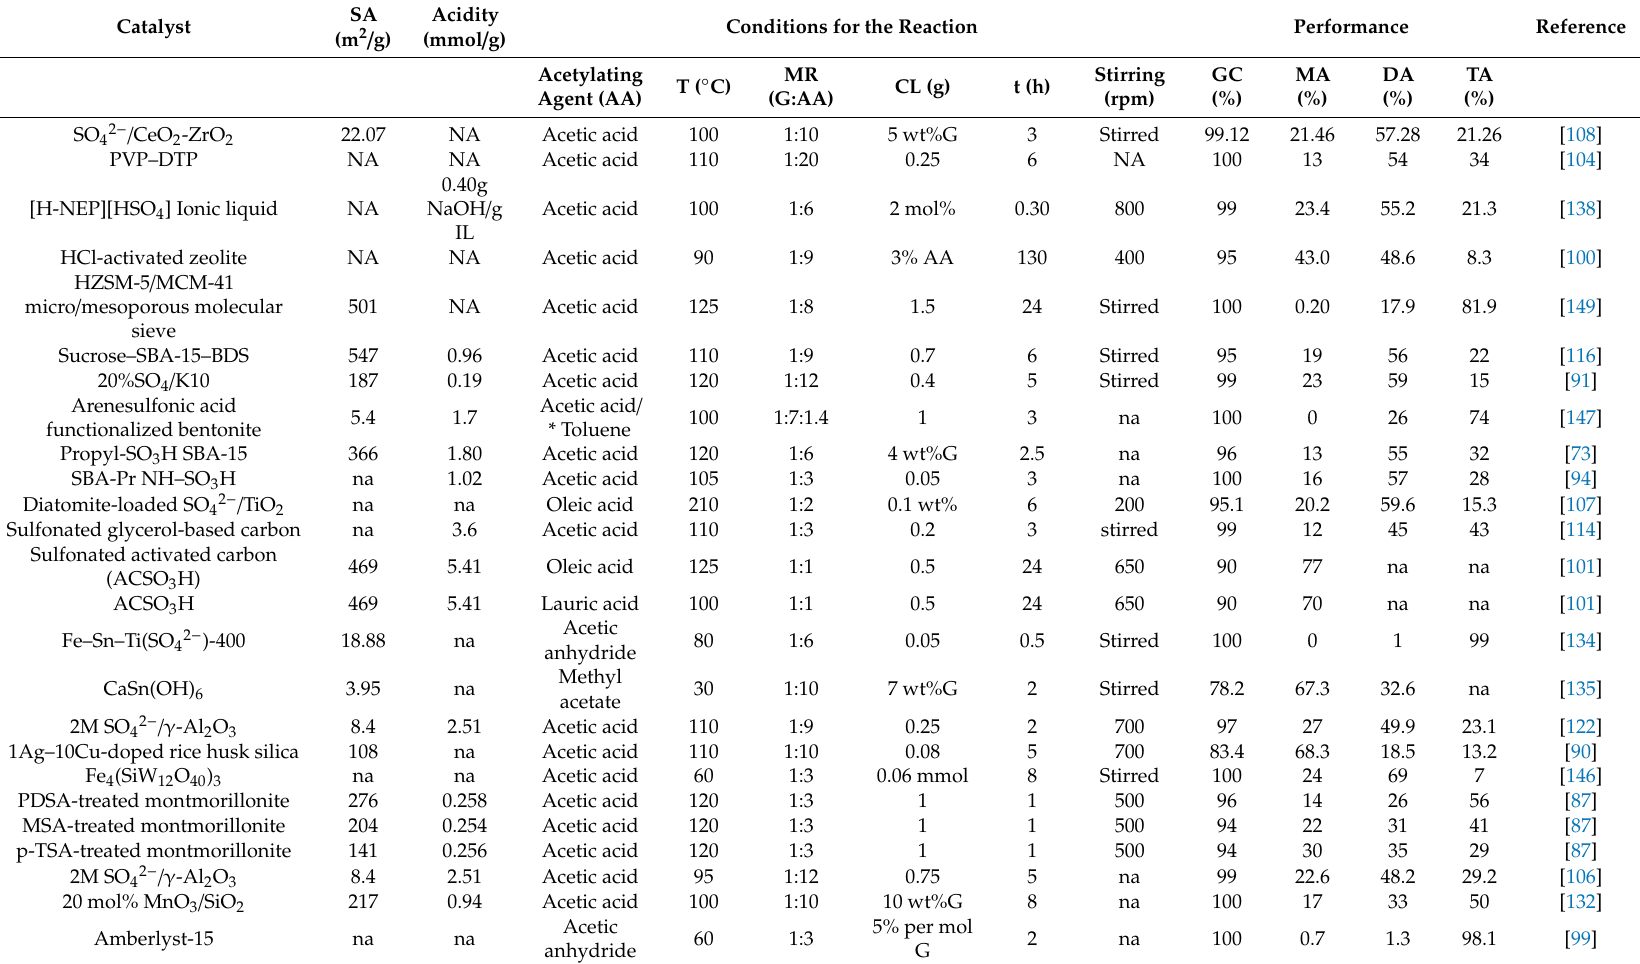
Table 2. High performing catalysts in glycerol acetylation as reported by recent